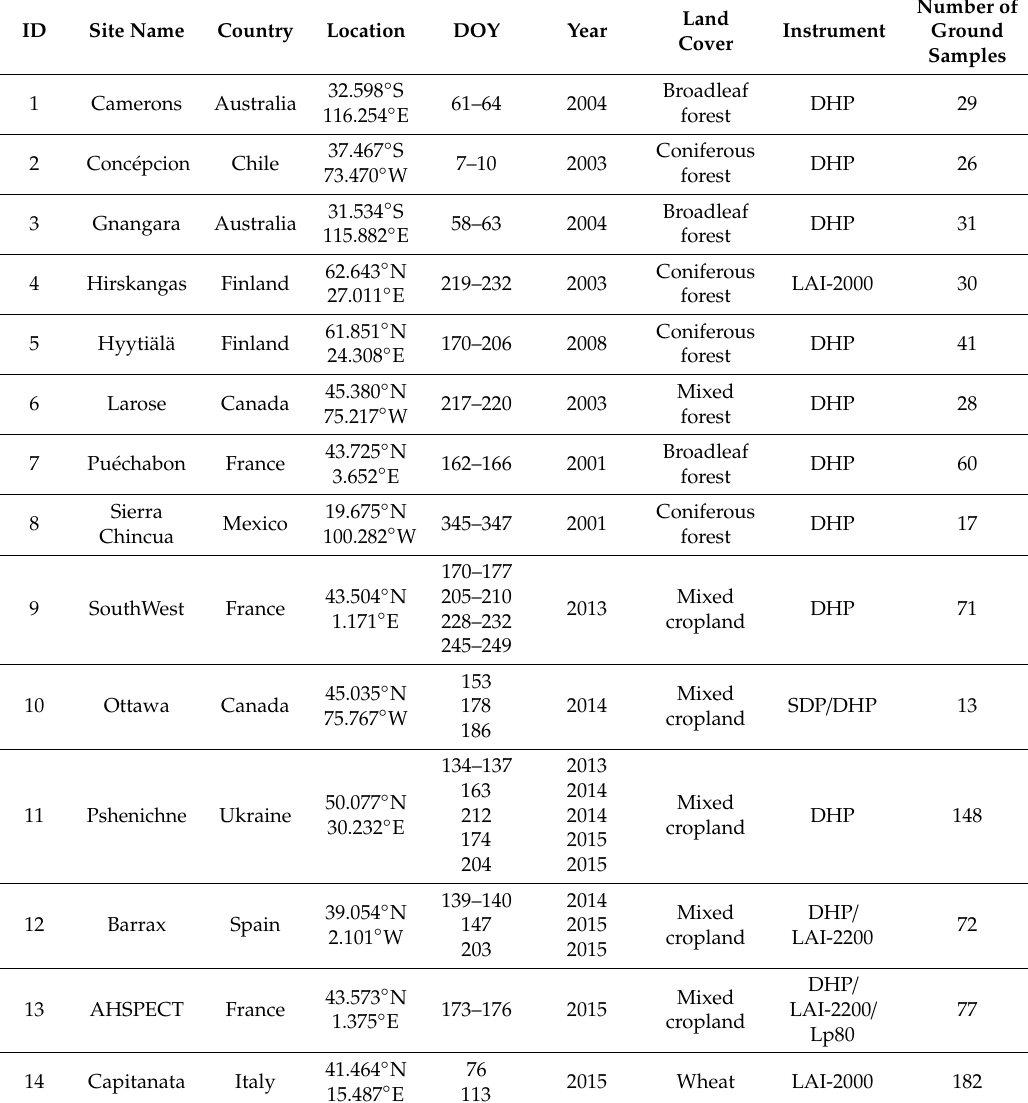
Table 1. Information on the selected sites in the basic research